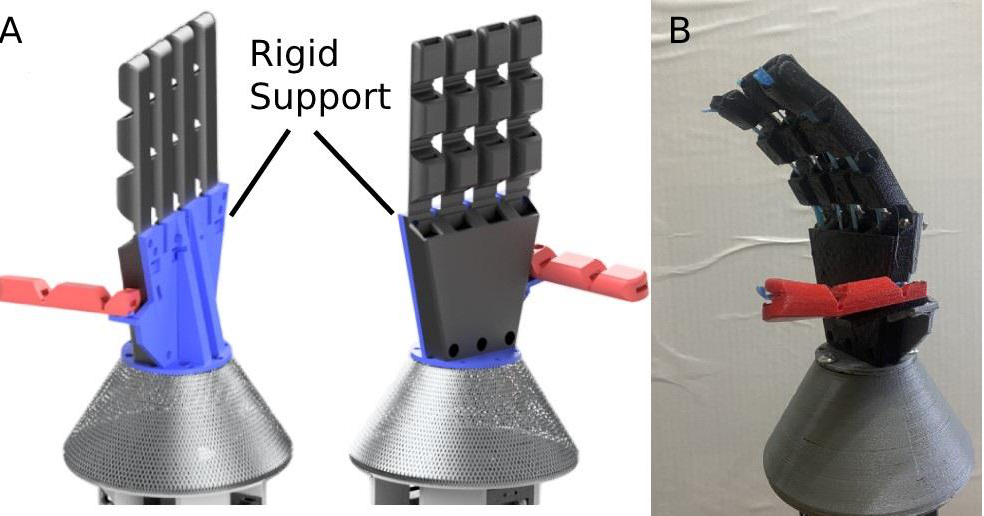
Figure 2. ( A ) The CAD model of the hand design with the thumb shown in red, the rest of the hand in black, and the PLA support structure connecting the two in blue. ( B ) An image of the manufactured hand.